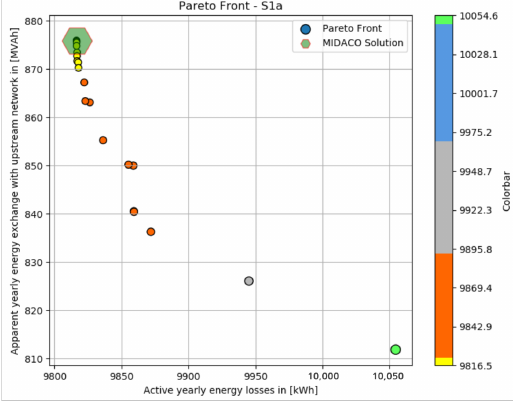
Figure 17. The Pareto front of the solved multi-objective optimization problem for Opt 2 (Figure